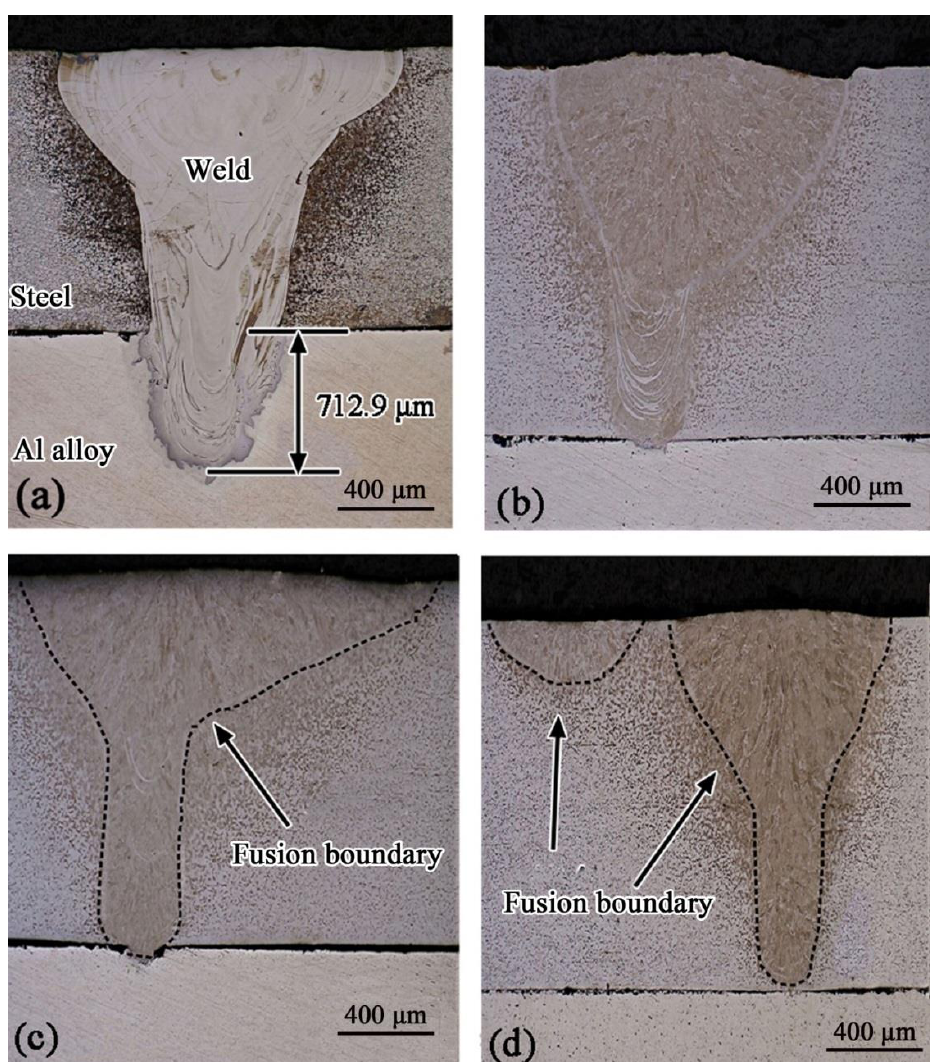
Figure 5. Effects of d 1 on cross sections of steel/Al joints produced by dual-beam laser welding with side-by-side configuration while the Rs of 1.5, the P L of 3000 W, the v of 33 mm/s, and the ∆ Z of 0 mm were fixed: ( a ) 0.5 mm; ( b ) 1.0 mm; ( c ) 1.5 mm; ( d ) 2.0 mm.